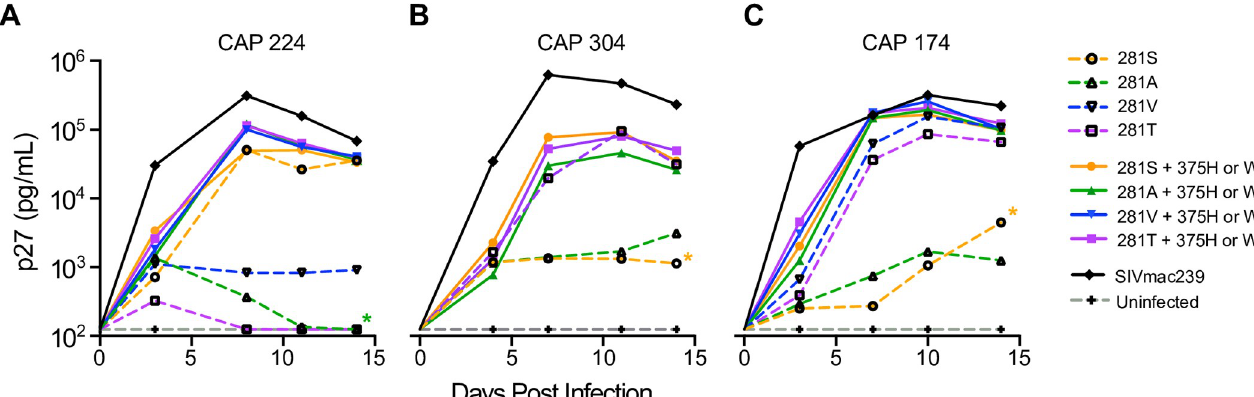
Fig 5. In vitro replication of SHIV 281/375 mutants. We tracked in vitro replication of each Env281/375 polymorphism for (A) CAP224, (B) CAP304, and (C) CAP174 by measuring p27 levels in activated primary rhesus CD4 + T cells over the course of 14 days. Individual SHIVs were used to infect 10 6 activated rhesus CD4 + T cells at a MOI of 0.01. Culture supernatants were collected over 14 days, with media replacement at each collection time-point to maintain cultures in 2 mL total volume. Viral p27 protein was quantified by ELISA. Env375 mutants contain a histidine except for CAP224 which has a tryptophan mutation. Wildtype 281 virus cultures are denoted ( � ).